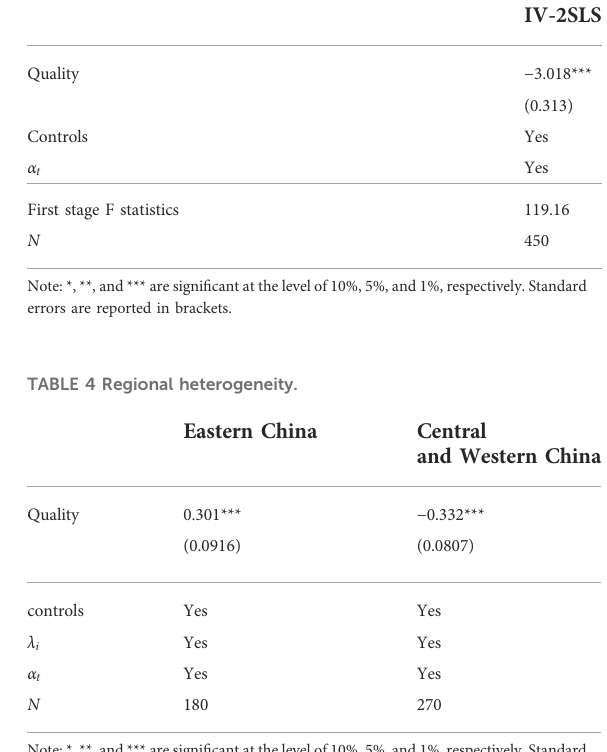
TABLE 3 Regression results of IV.